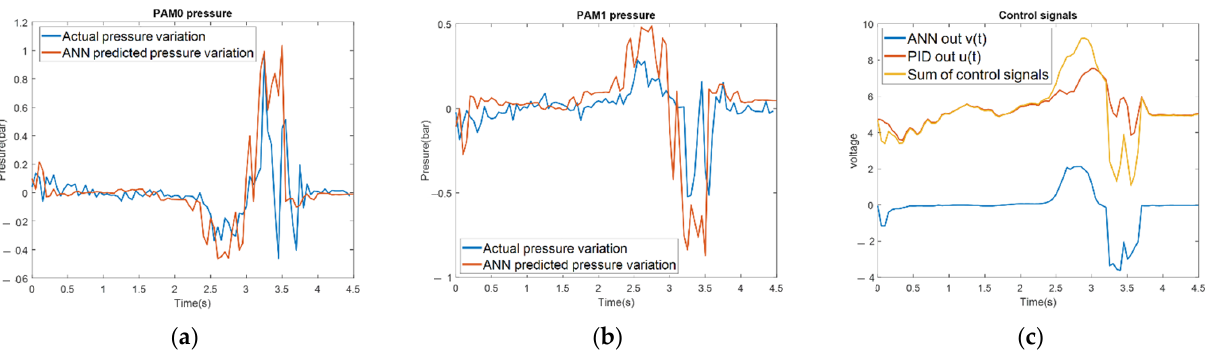
Figure 16. Controller signals. ( a ) PAM0 air pressure actual value and ANN predicted value; ( b ) PAM1 air pressure actual value and ANN predicted value; ( c ) control signal of feedforward ANN (IV) with PID.